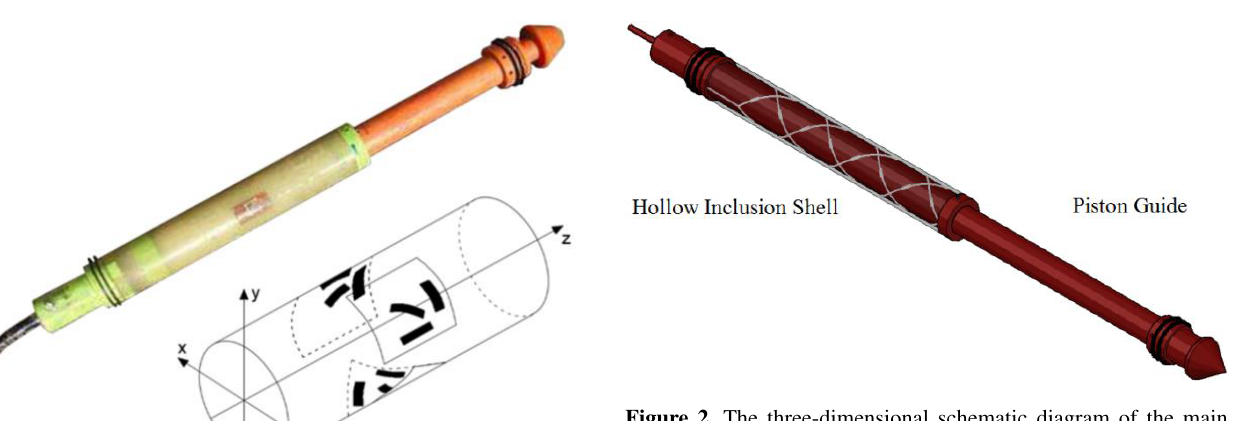
Figure 2. The three-dimensional schematic diagram of the main